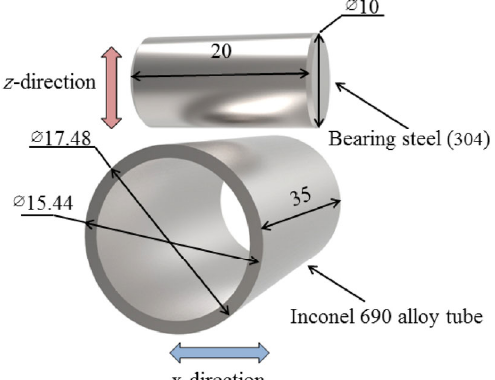
Fig. 6 Specimens used in the verification test (dimensions in